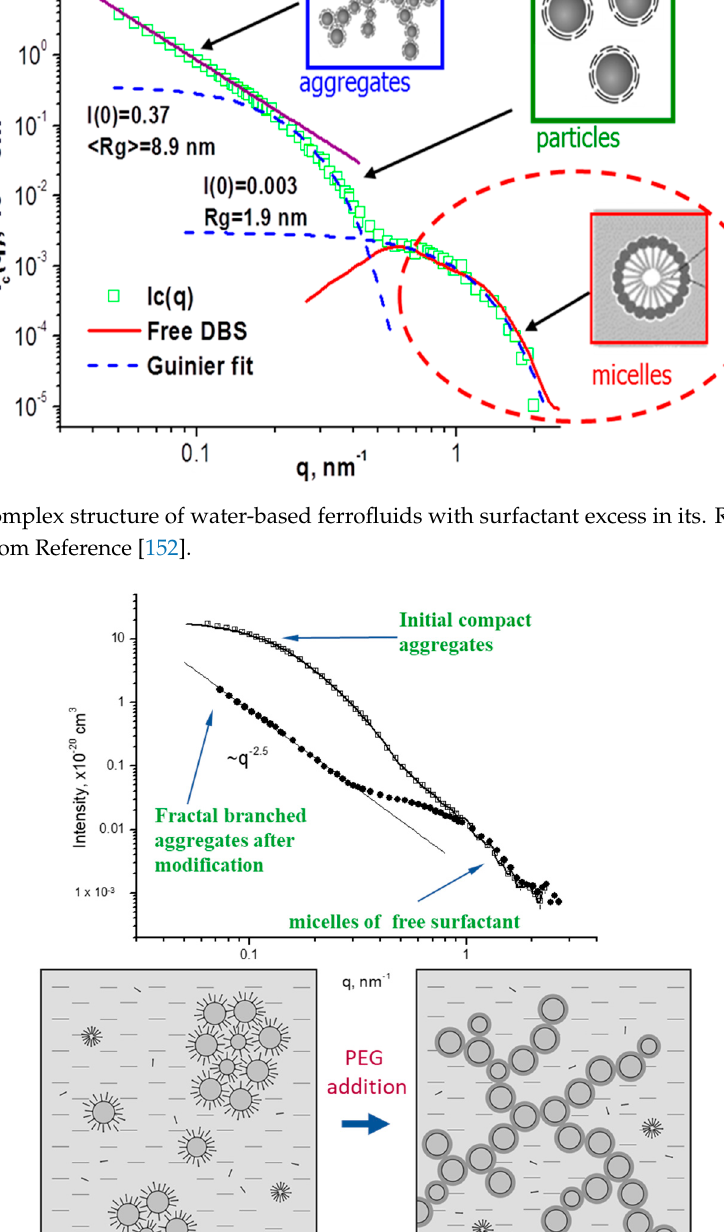
Figure 14. Behavior of magnetic nanoparticles in complex solutions of MNPs with amyloids (left) and with native (not aggregated) protein (right) according to small-angle X-ray scattering (SAXS) data. It’s also shown formation of some rod-like aggregates in solutions of MNPs with amyloids and there is no any change in MNPs solutions with native protein at various MNPs concentrations. Sketch of the found adsorption of MNPs on amyloids surface with increase of MNPs concentration according to TEM, SAXS and optical (Faraday rotation) results (bottom). Reprinted with permission from Reference [151].